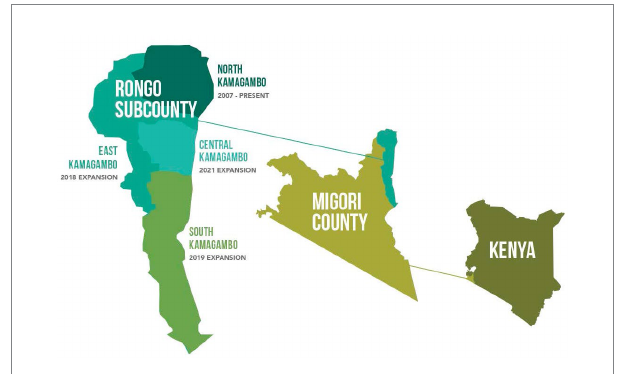
FIGURE 1 Rongo sub-county is located in the northeastern portion of Migori County, Kenya. It is further divided into four wards, which include North Kamagambo and East Kamagambo where programming took place prior to the study, South Kamagambo where programming commenced following the baseline study and Central Kamagambo, where training had not yet occurred at the end of the study period.